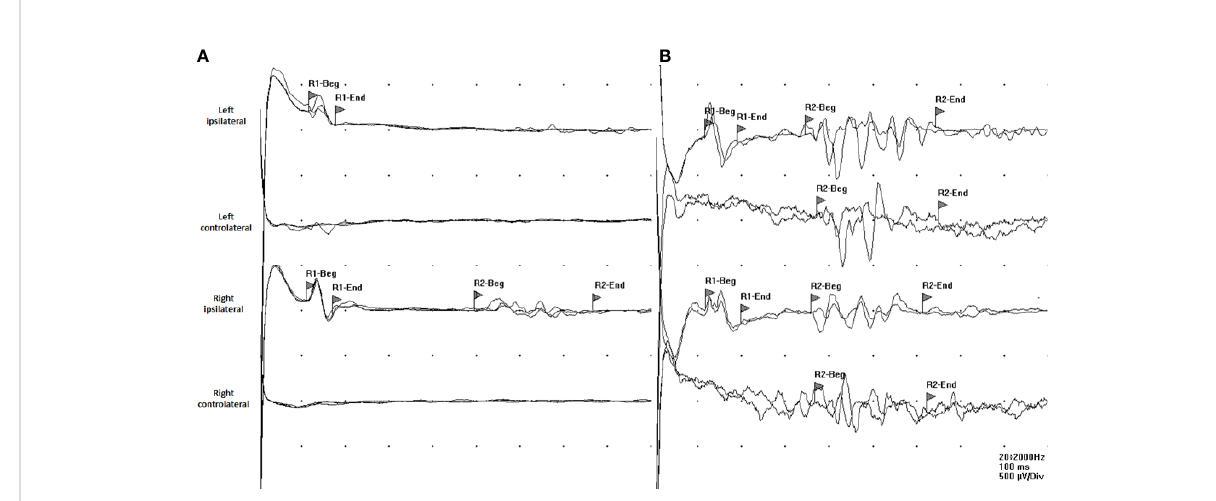
FIGURE 1 Recording from both orbicularis oculi muscles, stimulating the supraorbital nerve on each side. (A) Stimulating the left side results in a normal R1 response while ipsilateral and contralateral R2 components are absent. Stimulating the right side results in a normal R1 component, while the ipsilateral R2 response is delayed and the contralateral R2 component is absent. This feature is related to a bilateral alteration of the multisynaptic pathway between the nucleus of the spinal tract of V cranial nerve in the ipsilateral pons and medulla and interneurons forming connections to the ipsilateral and contralateral facial nuclei. (B) The blink re fl ex is